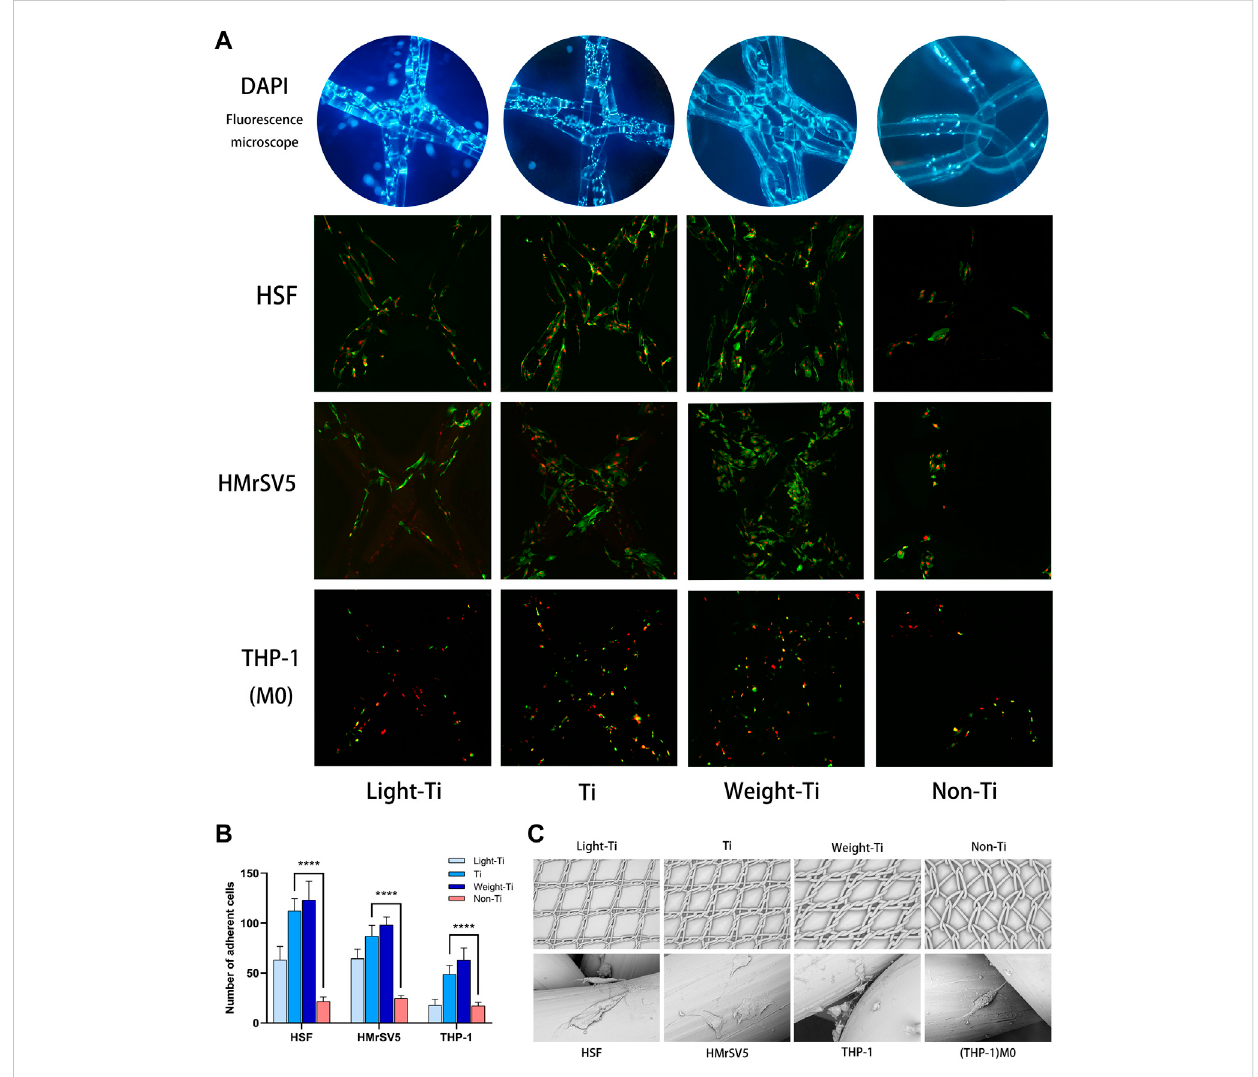
Cells growth onthe mesh. (A) Cellsgrowth onthemeshsurface (non-homogeneouscells, not the sameculture time)under fl uorescencemicroscopy (DAPI,1,000xmagni fi cation),andcellsgrowthonmeshsurfaces(all×48 h)underconfocalmicroscopy(z-axisimaging,×1000magni fi cation); (B)